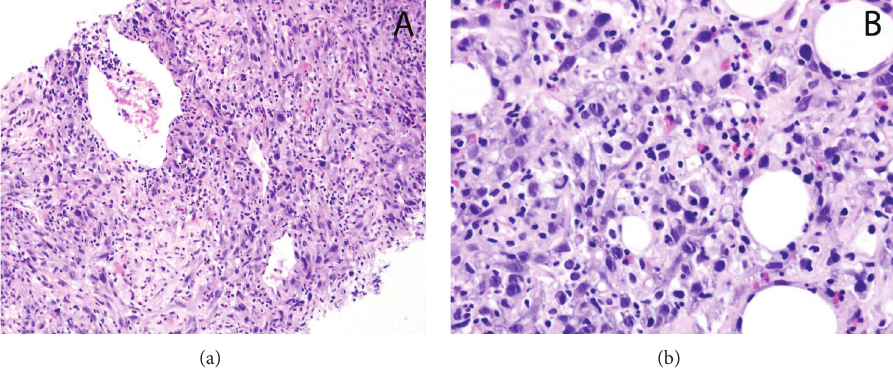
Figure 3: (a, b) Hematoxylin and eosin stains show malignant, spindle cells with mitotic figures.